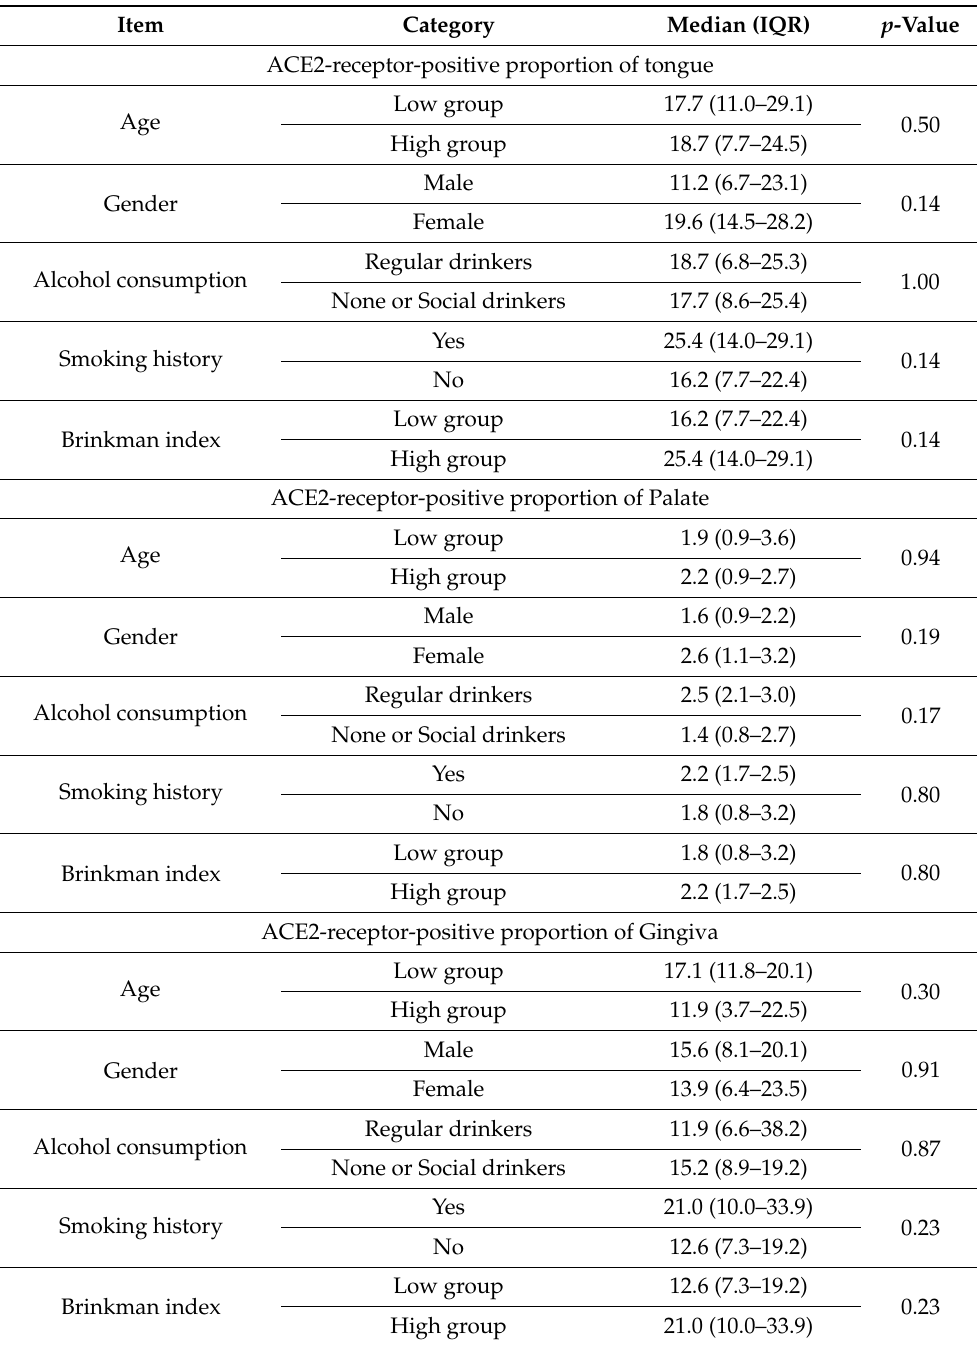
Table 3. Comparison between groups using Mann–Whitney U test (n =